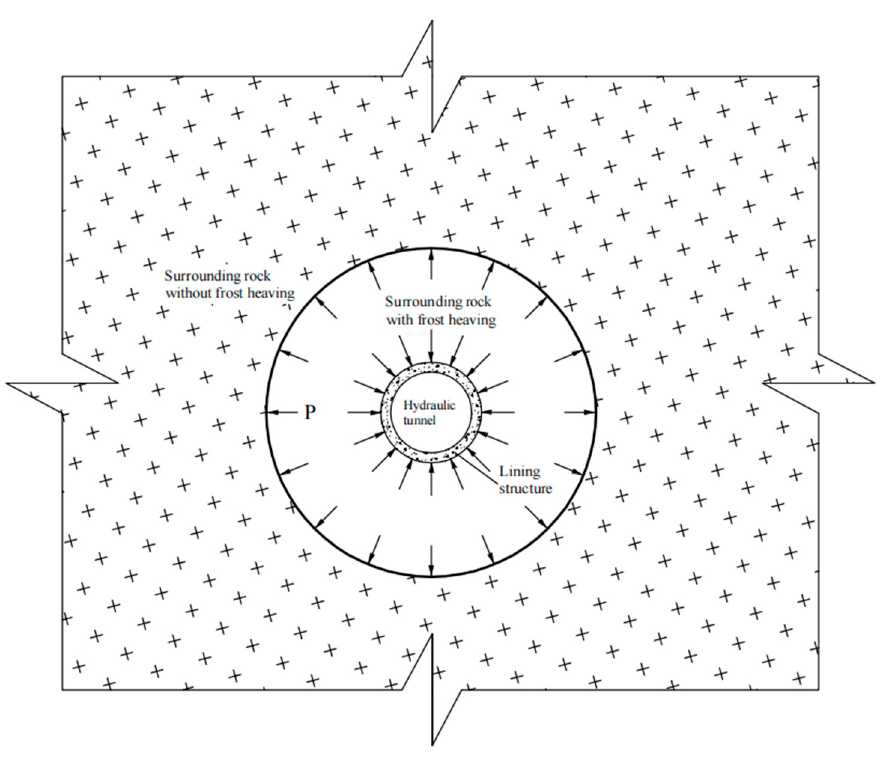
Figure 1. Schematic diagram of lining structure under frost expansion force.